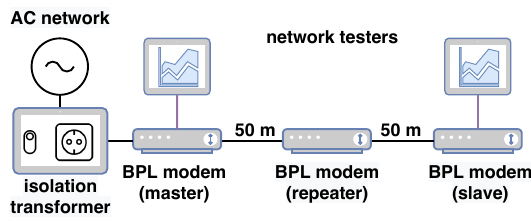
Figure 4. A2 topology—with repeater.